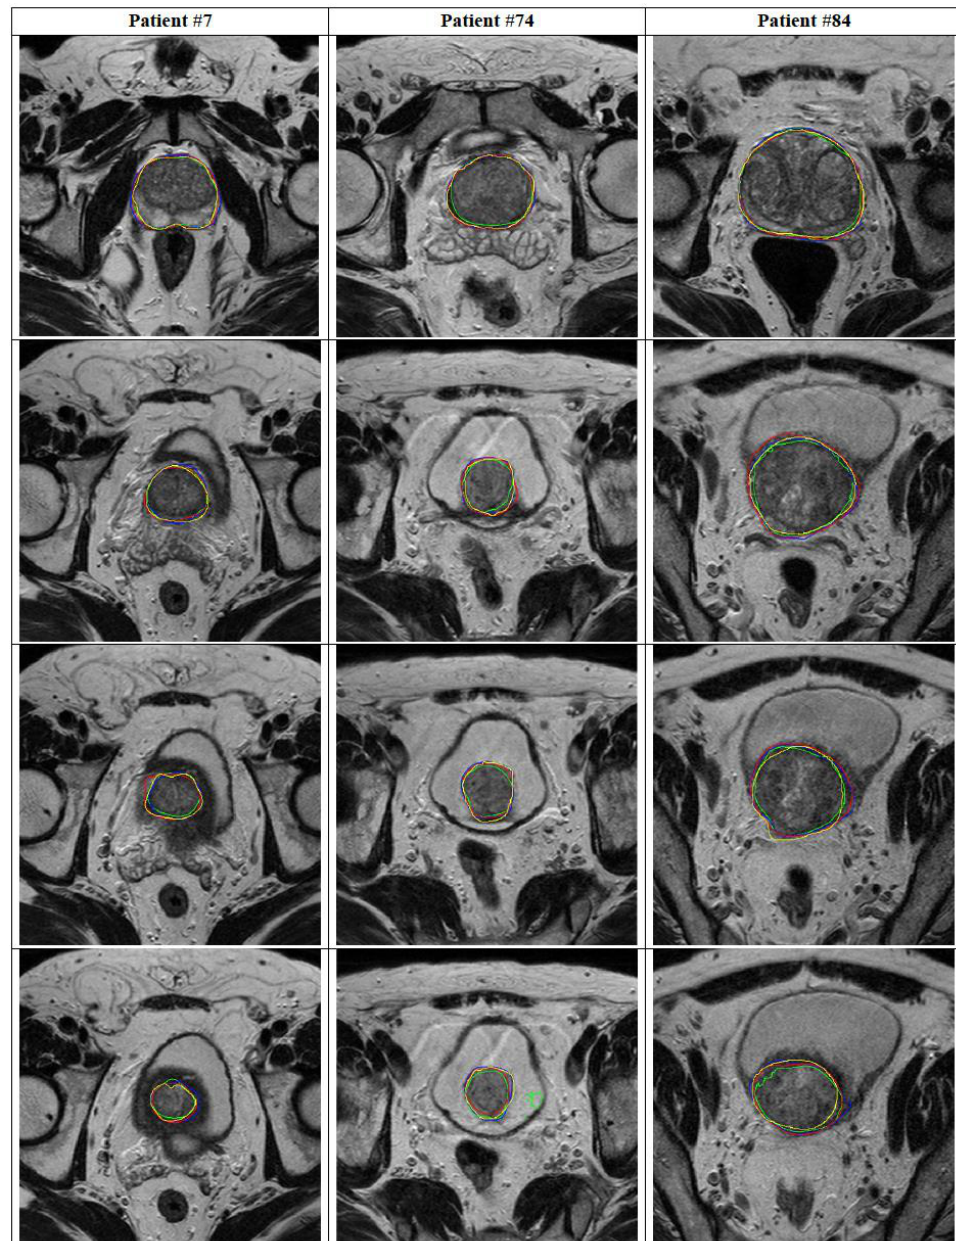
Figure 4. Comparison of segmentation performance for the three Net architectures in #7, #74, and #84 patients (four different slices for each patient). The manual segmentation (yellow), ENet (red), ERFNet (blue), and U-Net (green) are superimposed.